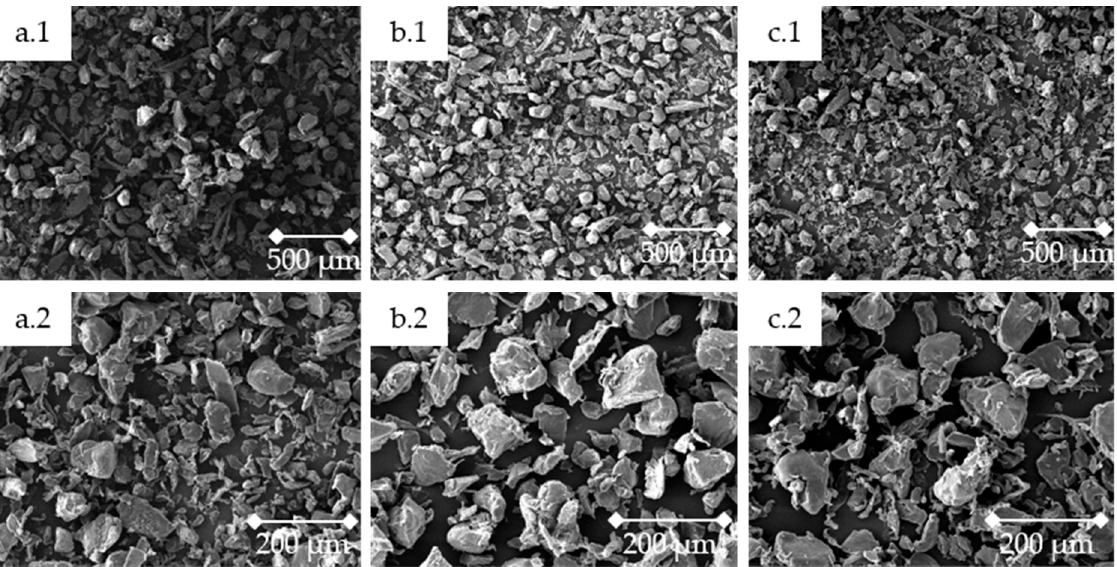
Figure 6. SEM images of the particles of used sinter material: ( a.1 , a.2 ) 1 h—15 rpm at 46 × and 150 × magnification; ( b.1 , b.2 ) 1 h—44 rpm at 48 × and 168 × magnification; ( c.1 , c.2 ) 96 h—44 rpm at 48 × and 168× magnification. Determined with Tescan Mira 3.